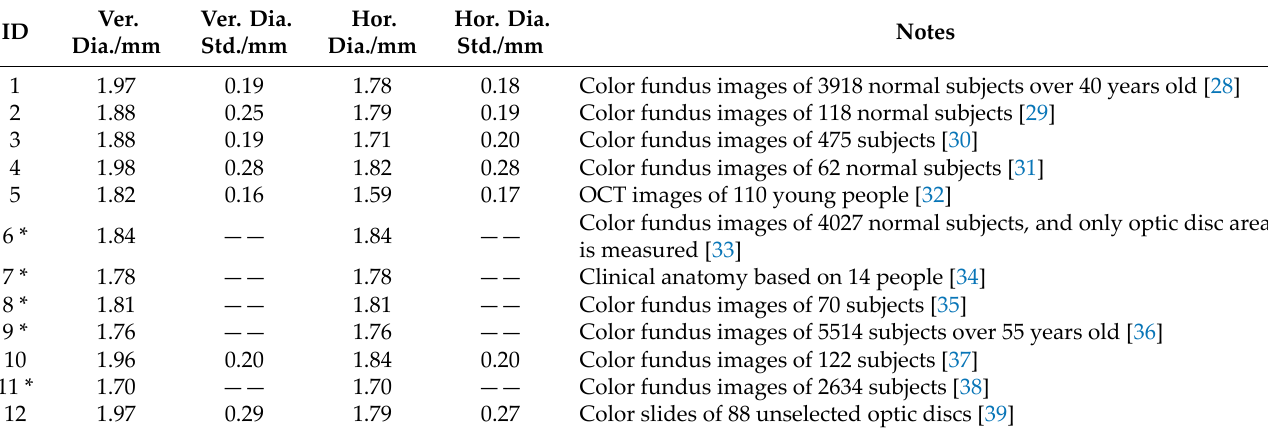
Table 1. Statistical sizes of human optic discs reported by the